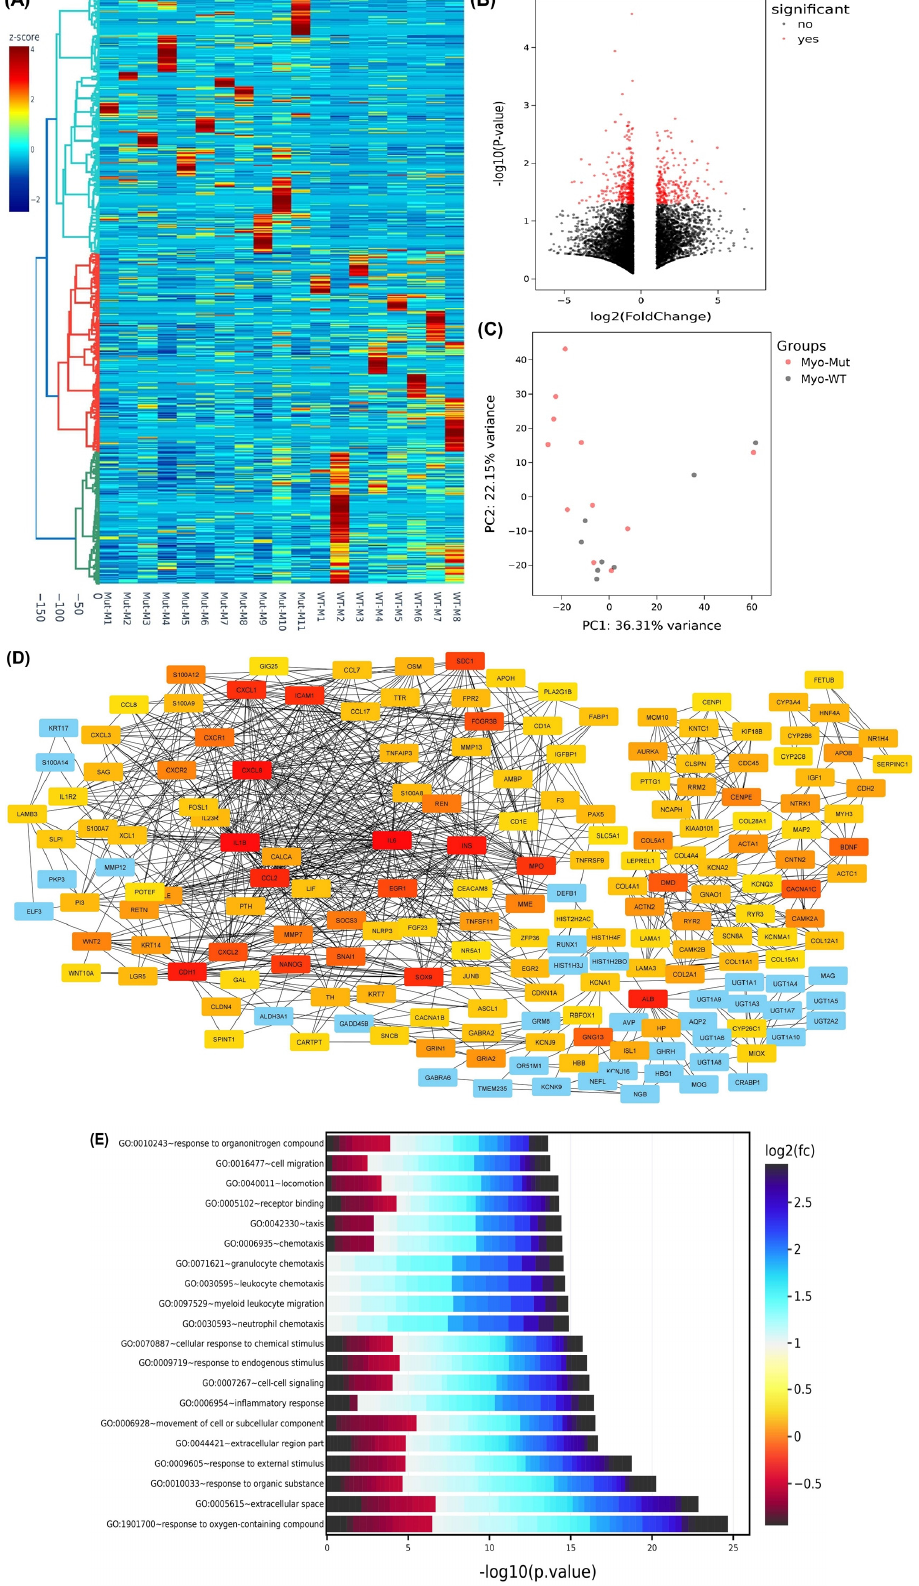
Figure 3. Heterogeneity and transcriptomic changes in myometrium specimens based on MED12- mutation status of their paired adjacent leiomyomas. ( A ) Hierarchically clustered heatmap analysis was performed in the myometrium comparing the MED12-mutated (n = 11) with the non-mutated (n = 8) group of their paired adjacent leiomyomas (fold change ≥ 1.5, p < 0.05). Color gradient repre- sents gene expression as z-scores. ( B ) Volcano plot showing up- (n = 2219) and downregulated genes (n = 4040) with a false discovery rate (FDR), p -value < 0.05, depicted as red dots. ( C ) Principal com- ponent analysis (PCA) plot of RNA-seq results in the myometrium comparing the MED12-mutated (n = 11) with non-mutated (n = 8) group of their paired adjacent leiomyomas. Each dot represents one sample. Myometrial samples from MED12 mutation-negative adjacent leiomyomas (Myo-WT) are shown in black and myometrial samples from MED12-mutated adjacent leiomyomas (Myo-Mut) are shown in red. ( D ) The protein–protein interaction networks were constructed with the Search Tool for the Retrieval of Interacting Genes (STRING) database and Cytoscape software version 3.9.1 using the 150 hub genes identified by the CytoHubba plugin of the Cytoscape software platform. The color of the nodes denotes interaction degree (from high to low degree: red, orange, yellow, and blue). ( E ) Gene ontology (GO) analysis of the identified differentially expressed 150 hub genes in the myometrium comparing the MED12-mutated (n = 11) with the non-mutated (n = 8) group of their paired adjacent leiomyomas (fold change ≥ 1.5, p < 0.05). Color gradient represents level of log2 fold change presented as z-scores.